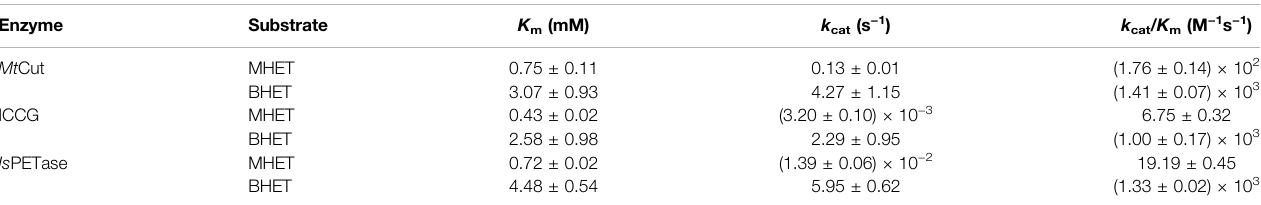
TABLE 2 | Kinetic hydrolysis parameters of MHET and BHET by Mt Cut, ICCG, and Is PETase a .